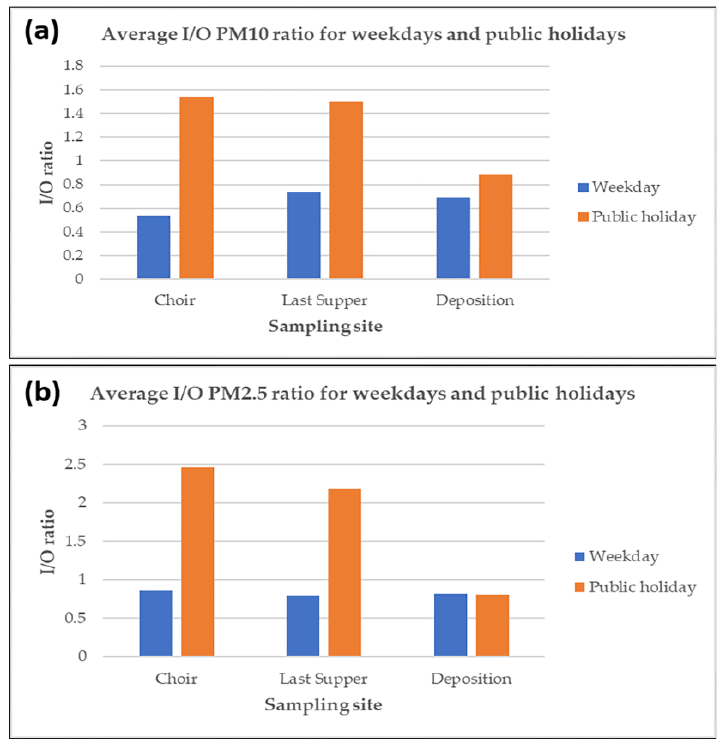
Figure 5. Average I/O ratio for ( a ) PM10 and ( b ) PM2.5 during the weekdays and public holidays for the three sampling sites.